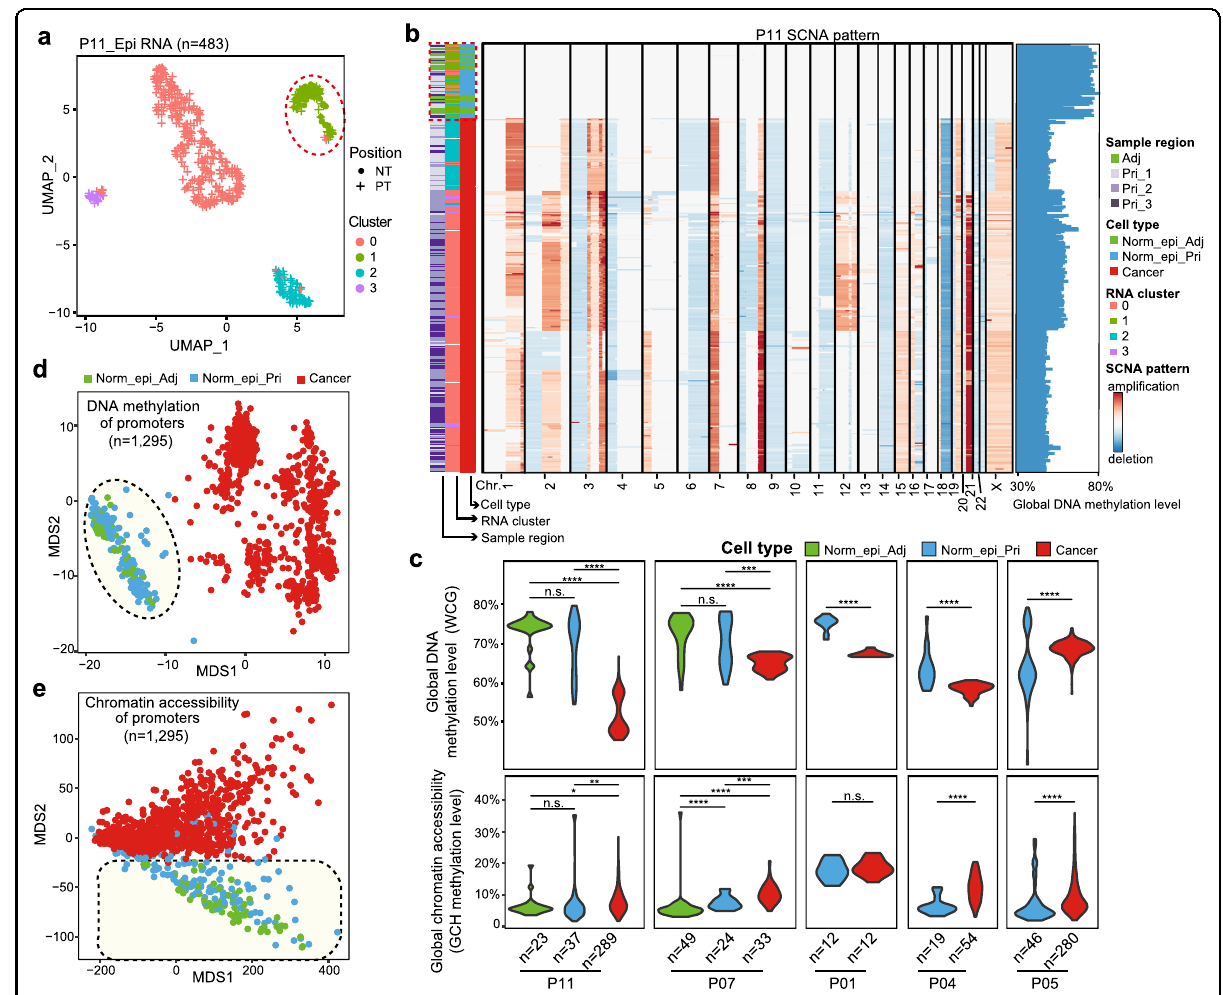
Fig. 1 Normal epithelial cells were identi fi ed in the primary PDAC tissues. a Unsupervised UMAP showing the clustering of epithelial cells using the transcriptome of P11. The red dashed line indicates epithelial cells in primary tumor tissue in the same cluster as those in adjacent tissue. b SCNA map showing the high frequency of subchromosome-scale SCNAs in P11. The red dashed line indicates that a signi fi cant proportion of epithelial cells in the primary tissue regions have euploid genomes and show similarity to epithelial cells in the adjacent tissue in RNA expression patterns. Other patients are shown in Supplementary Fig. S4. The bar plot on the right shows the heterogeneity of the global DNA methylation level among the cells. c Violin plot showing the global DNA methylation level and chromatin accessibility in the Norm_epi_Pri cells, Norm_epi_Adj cells and cancer cells of each patient. The statistical test was carried out using the Wilcoxon rank-sum test. n.s., no signi fi cance; * P < 0.05; ** P < 0.01; *** P < 0.001; **** P < 0.0001. Only patients with each type of epithelial cells >10 were shown. d MDS analysis of promoter DNA methylation levels for all epithelial cells (1295 cells) from all 13 patients. The shadow in the dashed line indicates the relatively uniform promoter DNA methylation pattern for the Norm_epi cells from both adjacent tissues and primary tumor tissues. e MDS analysis of promoter chromatin accessibility for all epithelial cells (1295 cells) from all 13 patients. The shadow in the dashed line indicates the differences between cancer cells and the two types of Norm_epi